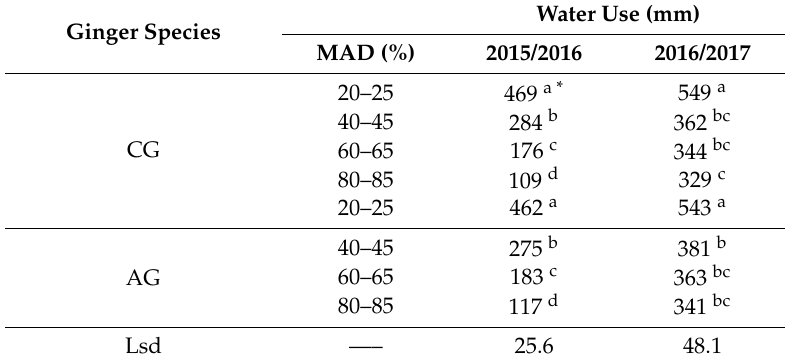
Table 5. Total water use during the growing season of two ginger species subjected to different irrigation regimes. Water Use (mm) Ginger Species MAD